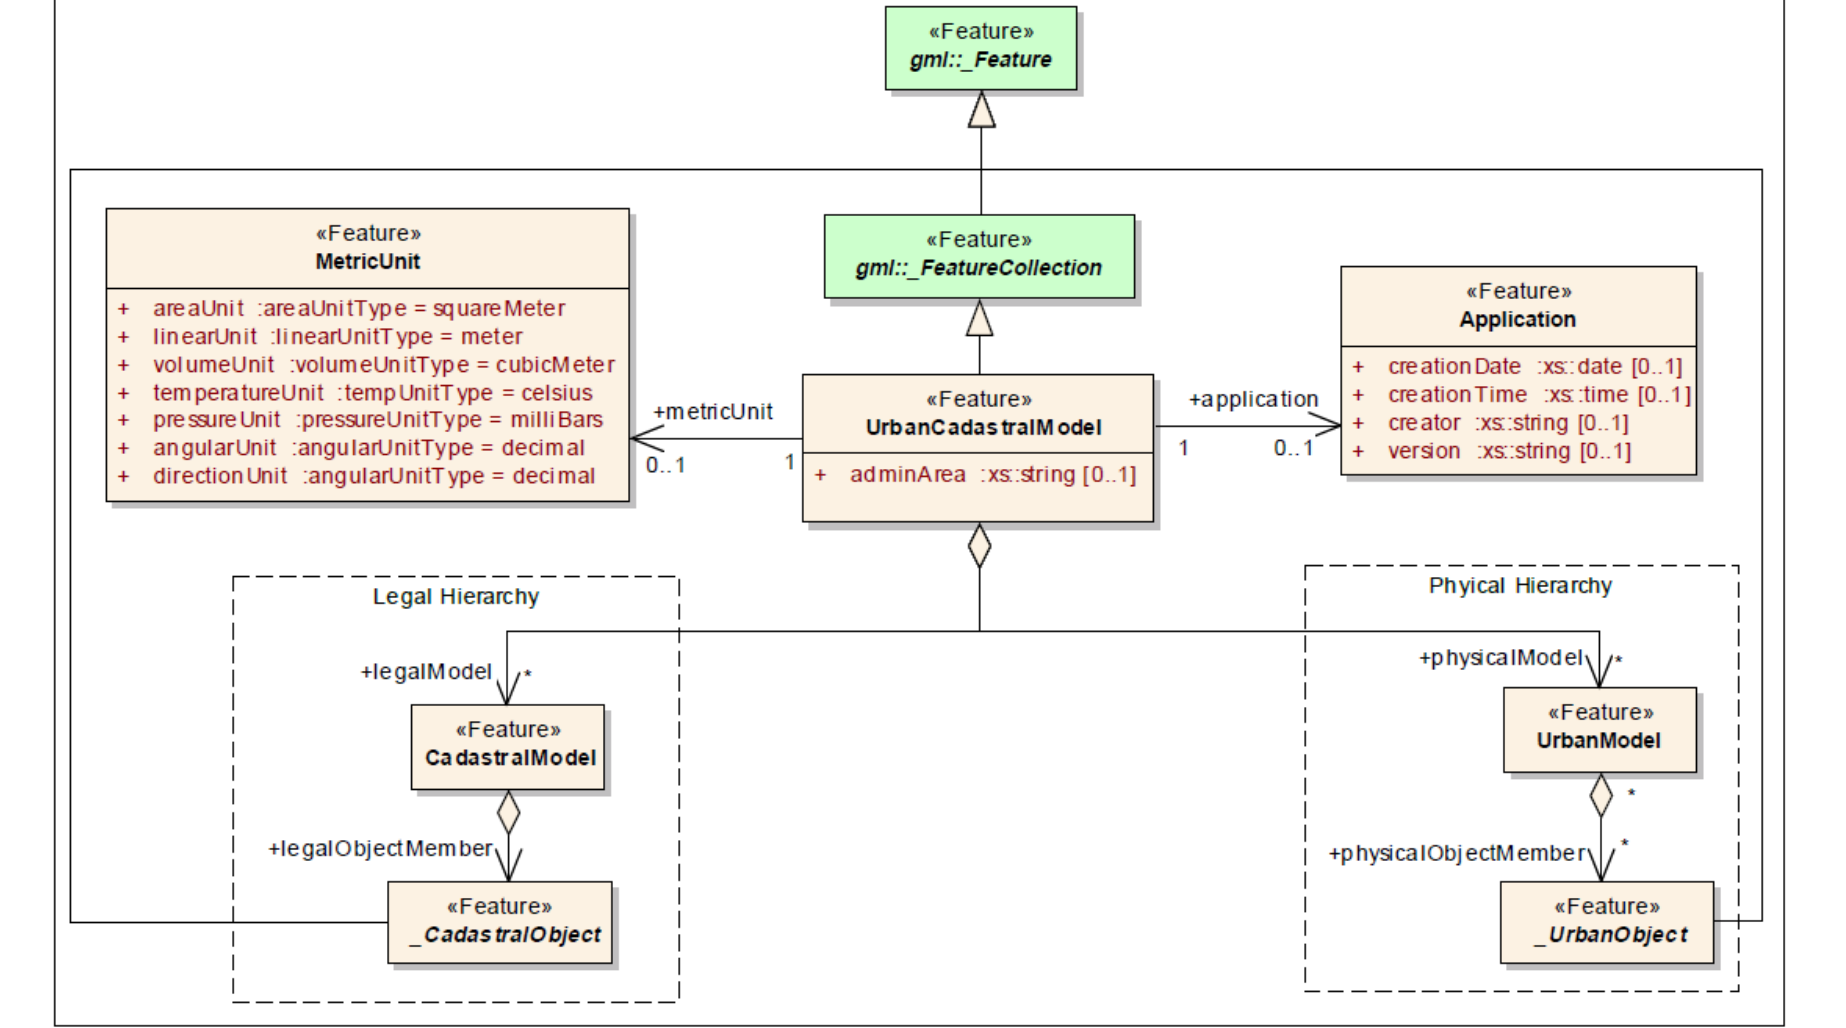
Figure 11. UML diagram of the 3DCDM Root